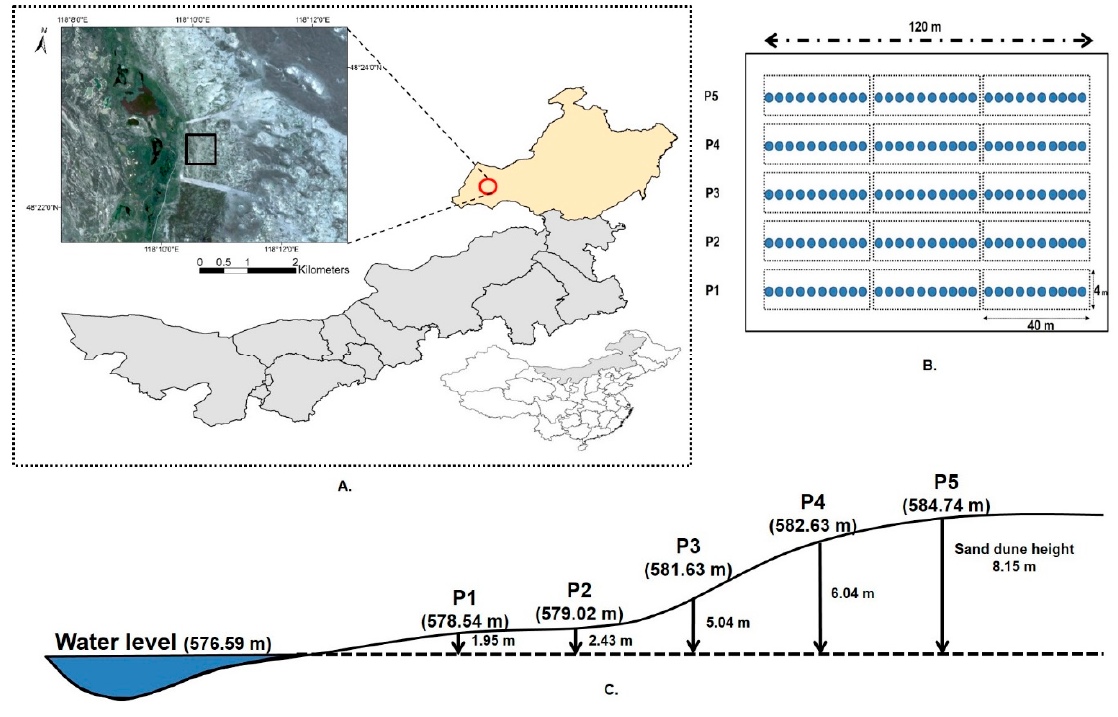
Figure 1. Study area and sampling sites in Hulunbeier, China. ( A ) Red circle: Location of the 2005 desertification combating project; black square: sampling sites for carbon isotope and intrinsic water use e ffi ciency (iWUE) analysis. ( B ) Location of the tree growth belt and 15 plots. ( C ) Vertical distance to the groundwater level. Sand dune height was measured above the level of the surrounding lake.